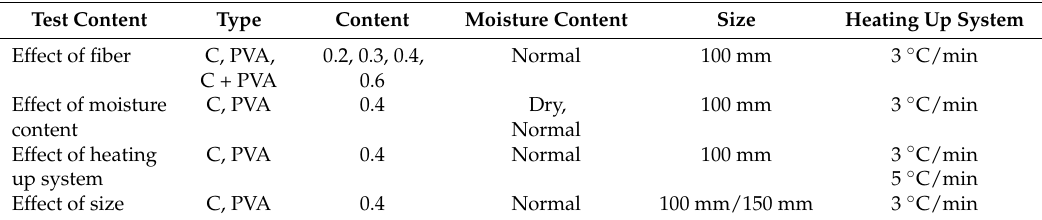
Table 3. The precise test conditions.